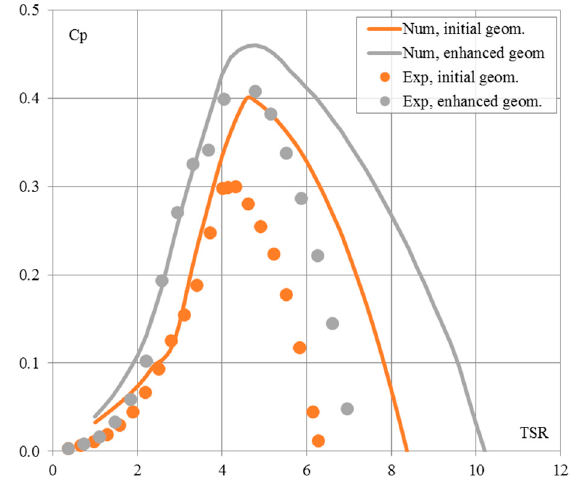
Figure 8. Cp vs TSR results—simulation and experiment.